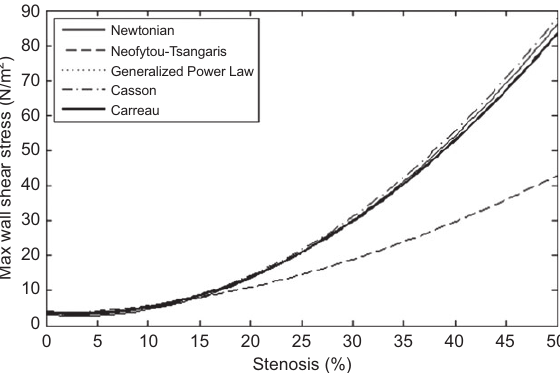
Figure 2 WSS vs. percent stenosis for various models, with 0.11196 m/s inflow rate.